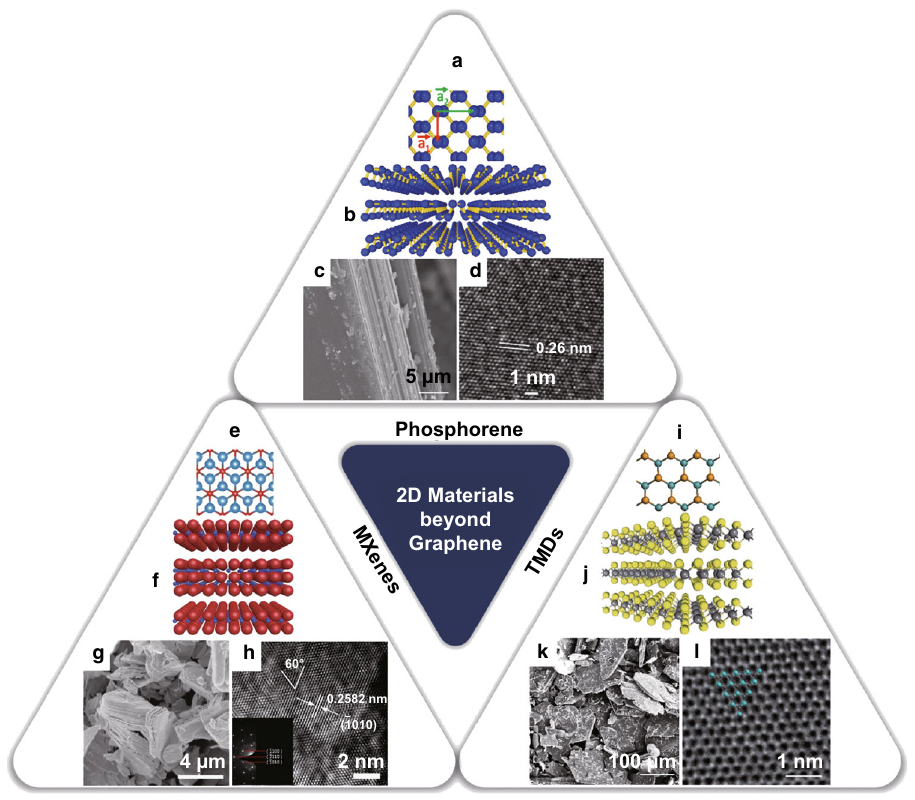
Fig. 3 Schematic representation of structure and atomic arrangement of the layered ‘‘beyond graphene’’ materials which are the focus of the present work: a , e , i Top view of the ball and stick atomic models of phosphorene, MXene, and TMD (MoSe 2 ), respectively. b , f , j Side view of the atomic models showing the layered structure of phosphorene, MXene, and TMD (MoSe 2 ), respectively. SEM images showing the characteristic layered structure of c , g , k SEM images showing the characteristic layered structure of phosphorene, MXene, and TMD (MoSe 2 ), respectively. d , h , i HRTEM image demonstrating the arrangement of the atoms in the lattice for phosphorene, MXene, and TMD (MoSe 2 ), respectively [24, 62–71]. Permission allowed by copyright